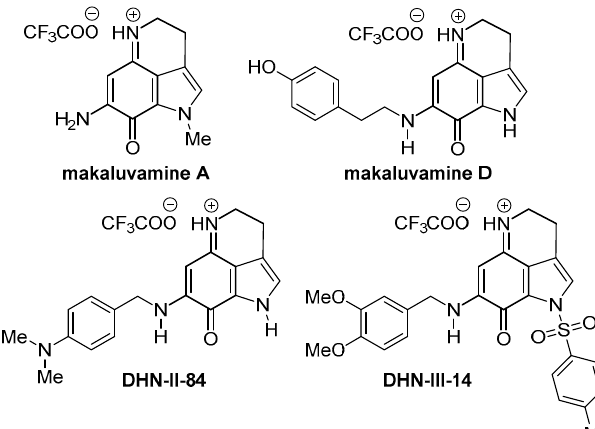
Figure 1. Chemical structures of makaluvamine A, makaluvamine D and the test compounds DHN-II-84 and DHN-III-14.